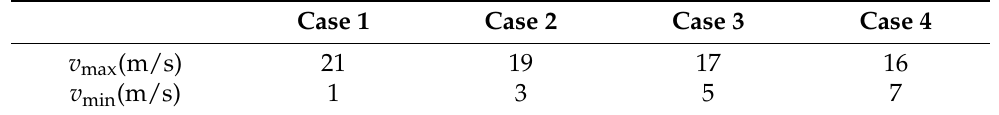
Table 1. Settings for 4 different cases in VC–PLKF.